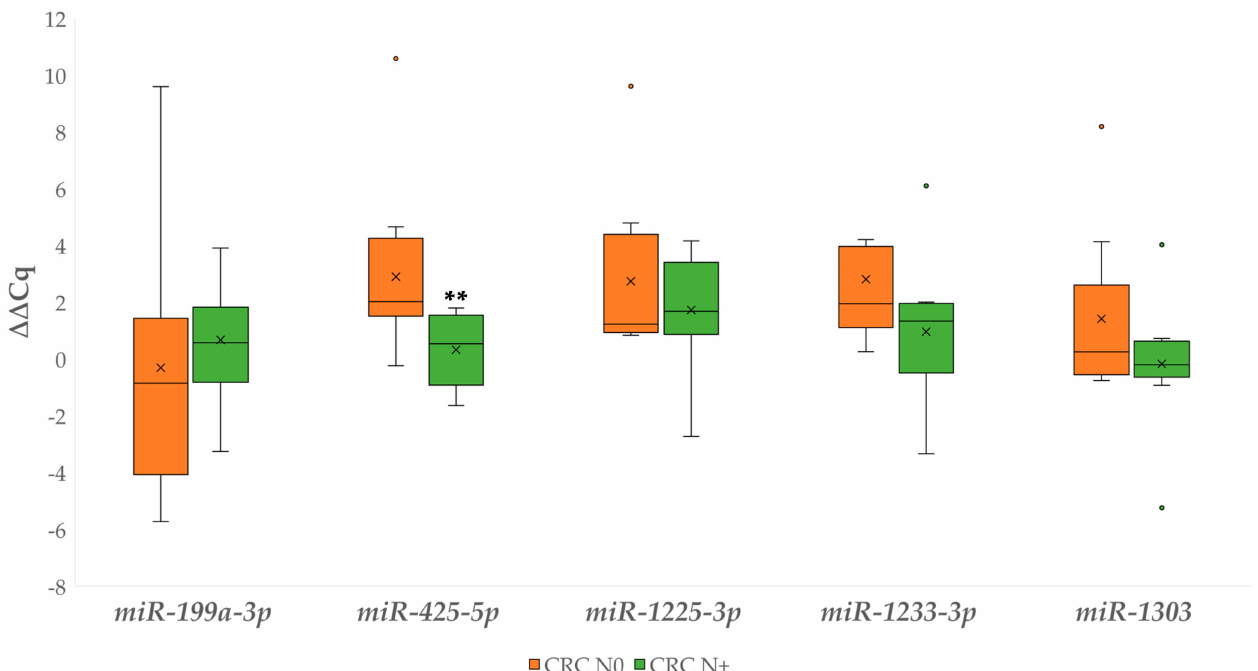
Figure 7. Expression ( ∆∆ Cq) of the investigated miRNAs in carcinoma without and with lymph node metastases. Legend: CRC N0, colorectal carcinoma without lymph node metastases; CRC N+, colorectal carcinoma with lymph node metastases; x, mean; ◦ , outlier; ** p ≤ 0.01.